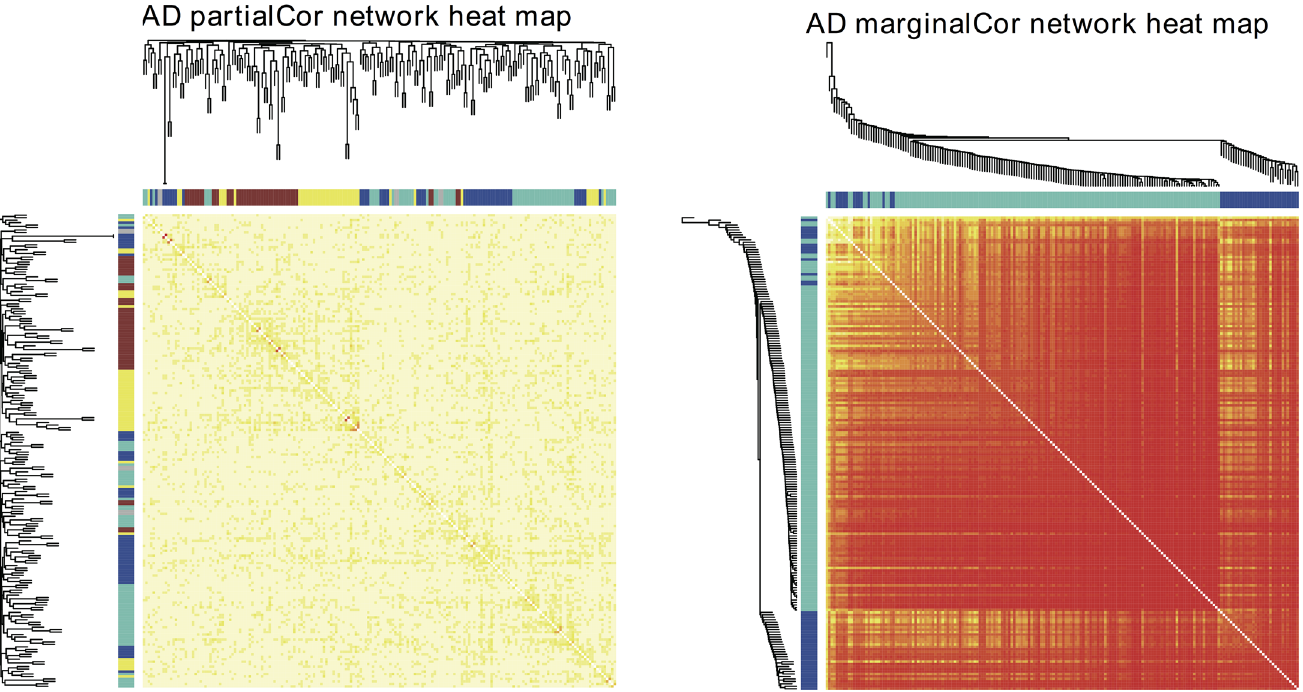
Fig 4. Heat maps of synaptic protein network in AD cohort where red indicates stronger correlation and the white indicates weaker correlation. The left and top color bars indicate the module membership of each protein (grey colored proteins do not belong to any module), with the corresponding hierarchical clustering dendrograms plotted. The left is the heat map based on partial correlations and the right is the heat map based on marginal